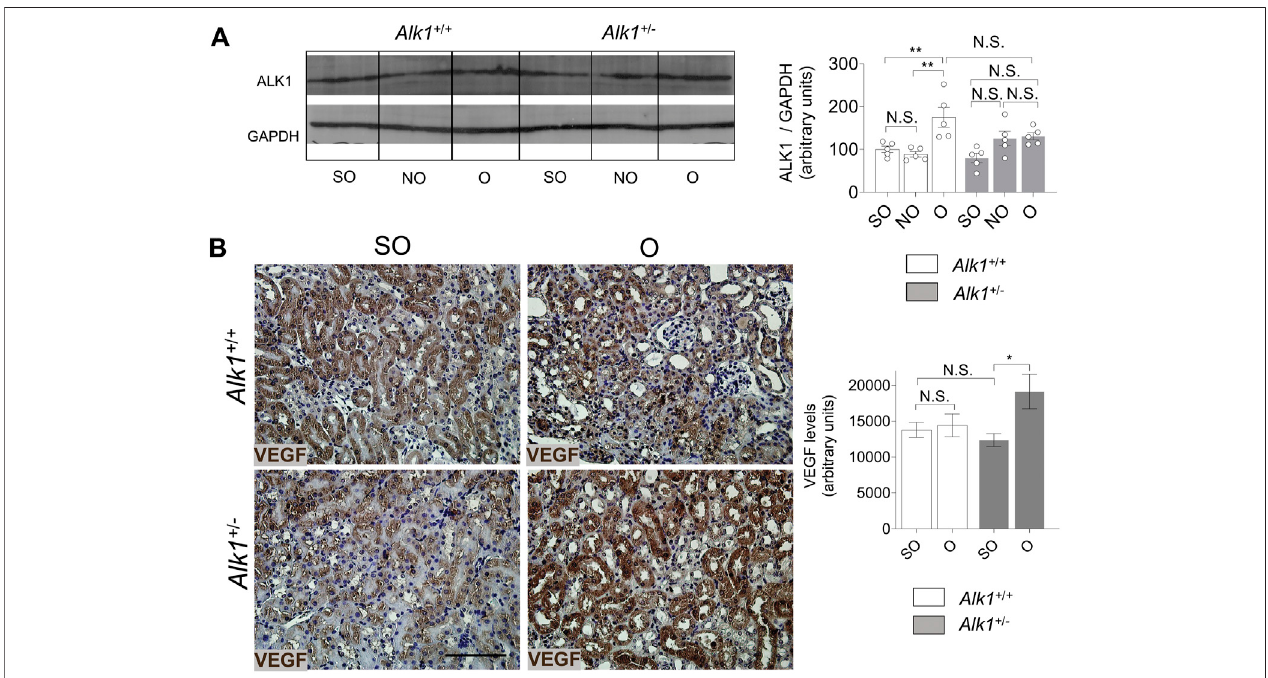
FIGURE 8 | ALK1 and VEGF protein expression after UUO. (A) Western blot analysis of ALK1 protein in SO, NO and O kidneys from Alk1 +/+ and Alk1 +/ − mice ( N = 5), and quanti fi cation of the corresponding densitometry analysis. Bars represent the ratio between the proteins and GAPDH, used as loading control. (B) VEGF immunohistochemistry representative pictures and quanti fi cation of VEGF levels (using Fiji software) in SO, NO and O kidneys from Alk1 +/+ and Alk1 +/ − mice. * p < 0.05; ** p < 0.01 N.S. Non statistically signi fi cant (Two-way ANOVA). Scale bar = 150 microns.